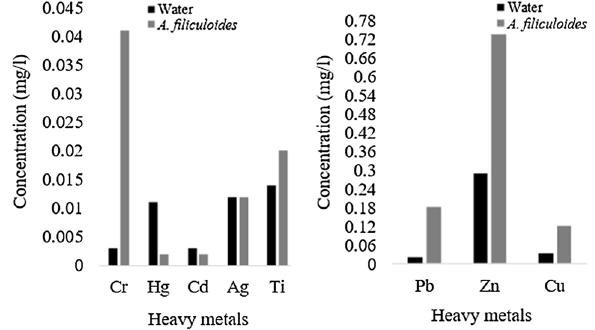
Fig. 4 Concentration of heavy elements in the samples of water and A. filiculoides in the western part of the